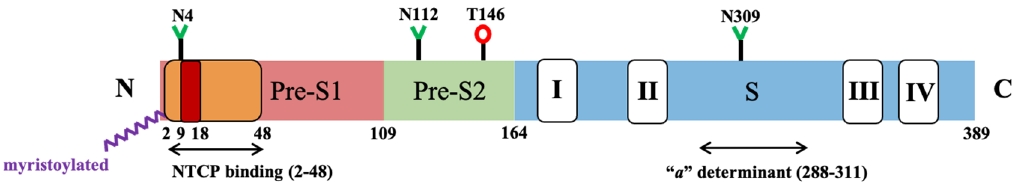
Figure 1. Composition of the HBV large surface protein. pre-S2, and S regions. Depending on the genotype, the pre-S1 region is in the size of 108, 109, or 119 amino acid (aa) residues. This graph is exemplified by the genotype D, where the pre-S1 region contains 108 aa. The pre-S2 and S regions contain 55 and 226 aa, respectively. The domain aa 2 to 48 in the pre-S1 region binds to NTCP to facilitate viral entry, where the aa 9–18 is the essential motif for the binding. The Gly2 residue is myristoylated, which is also important for the LHBs binding to NTCP. The S region contains 4 TM domains (I, II, II, and IV). The region aa 288–311 is the “ a ” determinant region, which is essential for induction of a protective humoral immune response by infection and vaccination. The common glycosylation sites on the protein include N-glycosylation at N4, N112, and N309, and O-glycosylation at